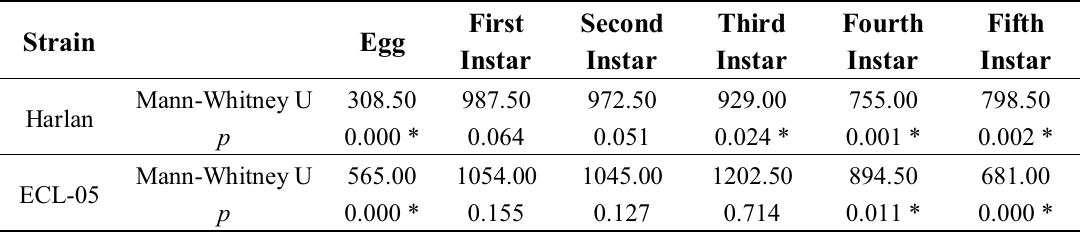
Table 7. Differences in Harlan and ECL-05 development from egg to fifth instar. Strain Egg